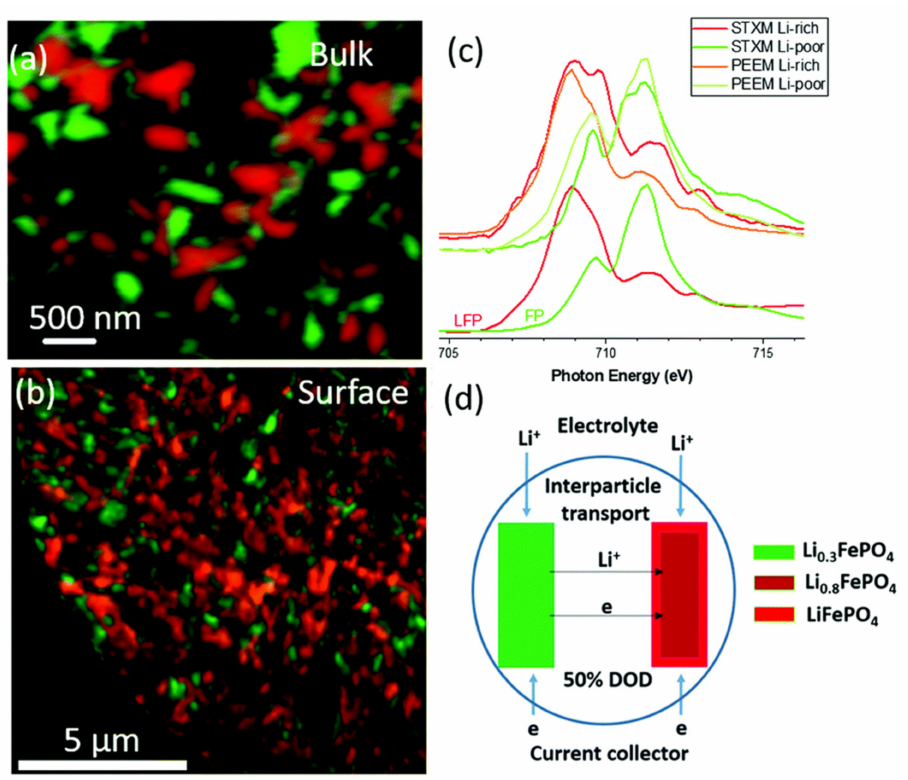
Figure 3. ( a ) Bulk Li concentration map obtained from STXM ( b ) Surface Li concentration map obtained from PEEM ( c ) XANES spectra of Li rich and deficient sites ( d ) Illustration of variation in concentration of surface and bulk Li particles with interparticle transport mechanism. (adapted with permission from Ref. [44]. 2020 The Royal Society of Chemistry).